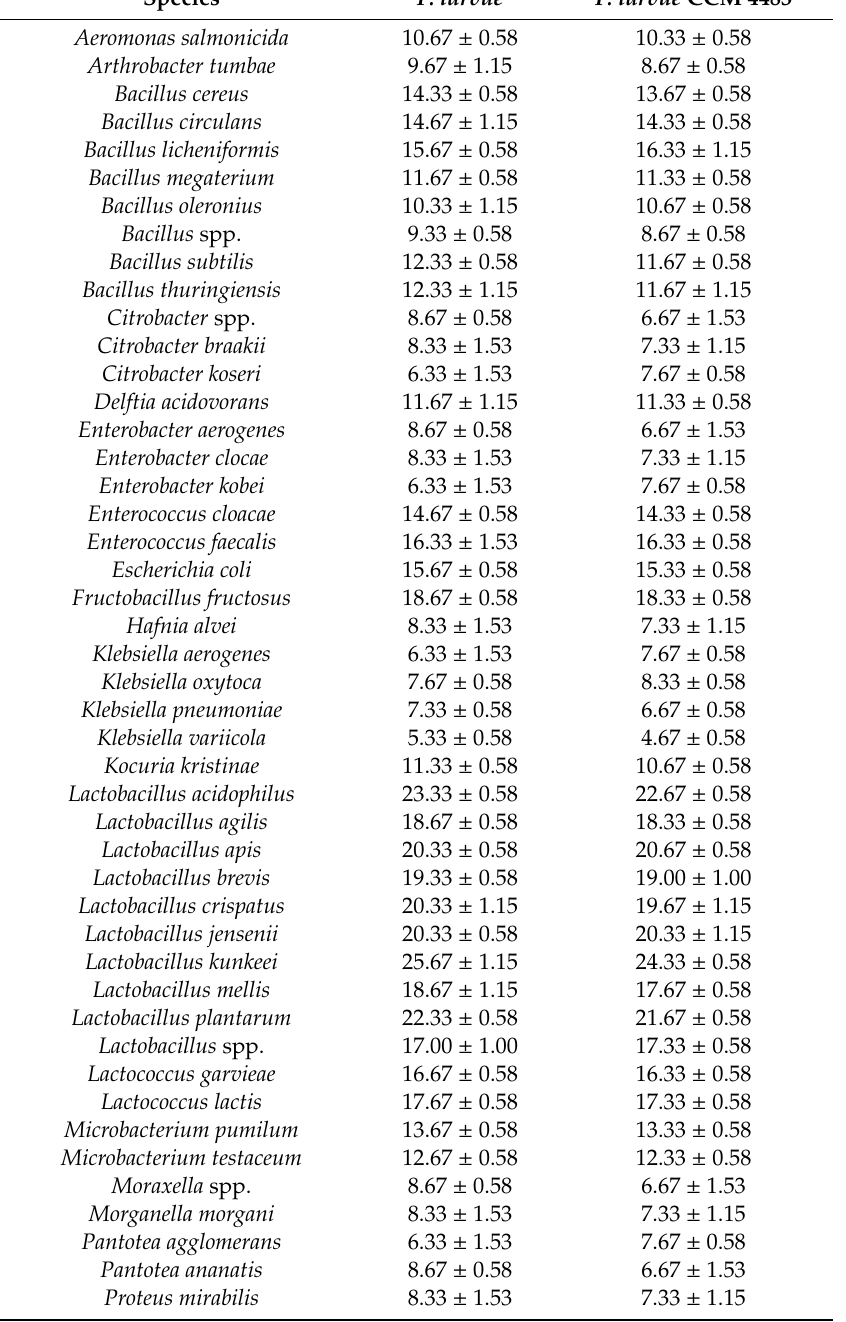
Table 5. Antimicrobial activity of individual isolates against P. larvae in mm (mean ± SD of three